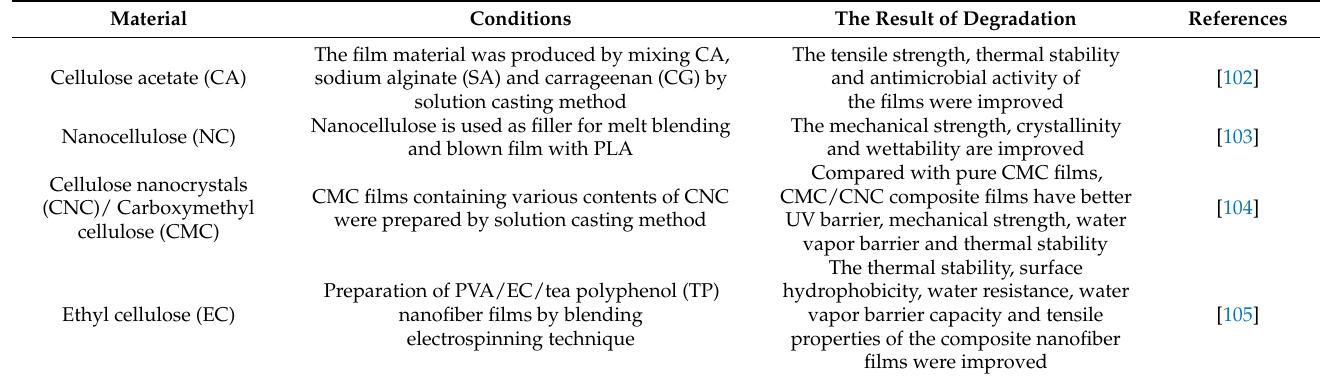
Table 5. Examples of cellulose derivatives film formation.